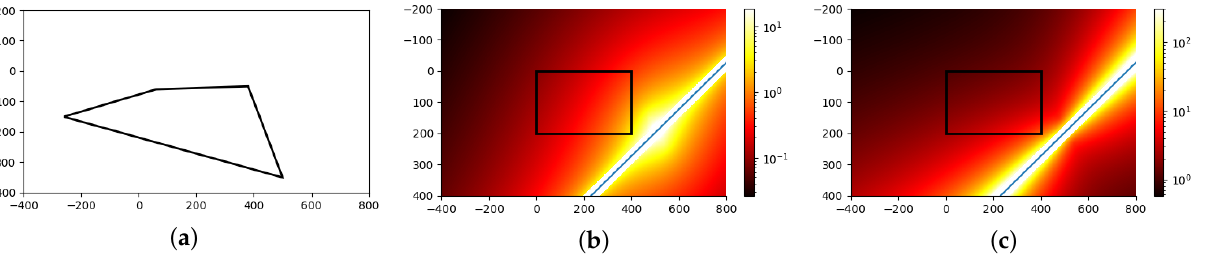
Figure 8. The heatmaps of the semi-minor and semi-major axis lengths: ( a ) the source quadrangle F , ( b ) semi-minor axis lengths, and ( c ) semi-majorFL axis